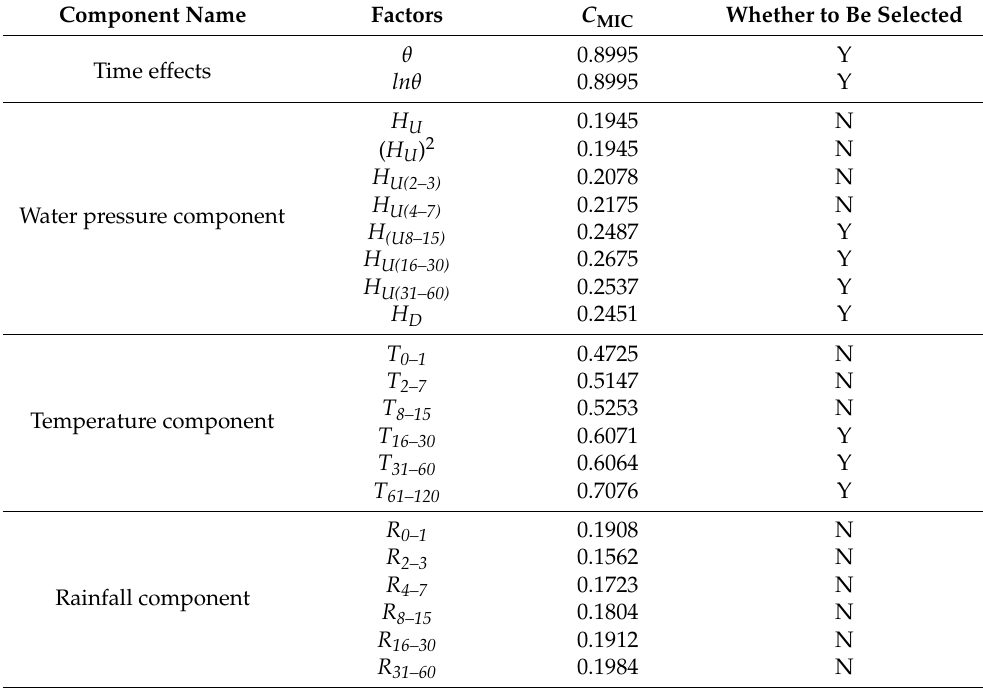
Table 4. Impact factor